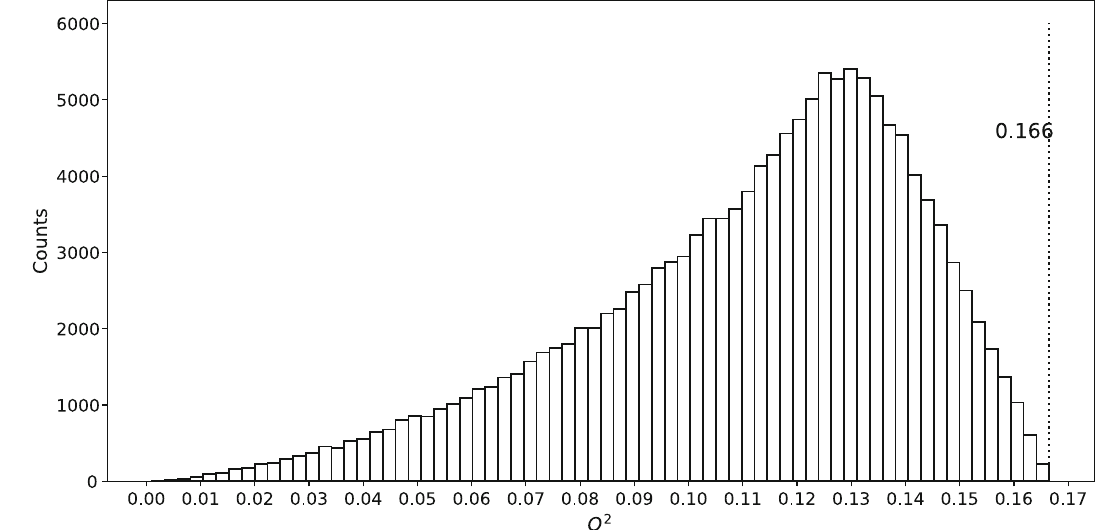
Fig. 1 With random choices of the ( x i , y j ) values, the occurrence frequencies of values of Q 2 are plotted using 1 . 44 × 10 5 data points generated